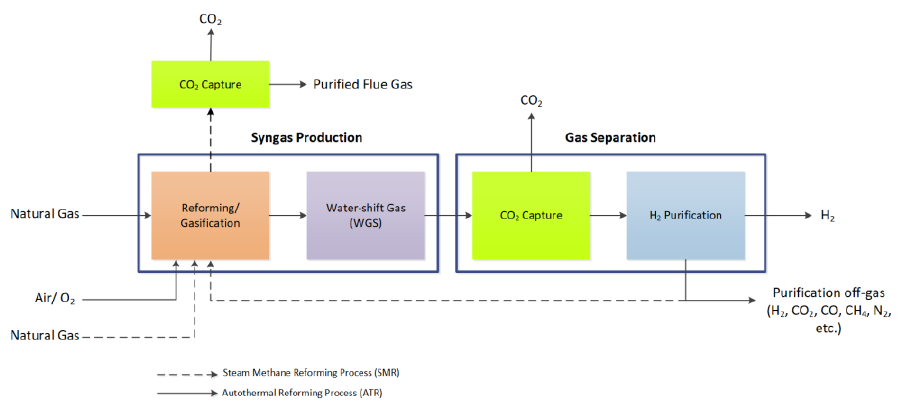
Figure 1. The blue hydrogen process flow: SMR and ATR.